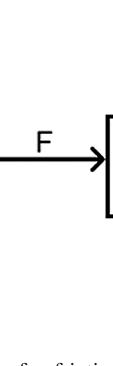
FIG. 7. Figure for friction post-test problem 3.